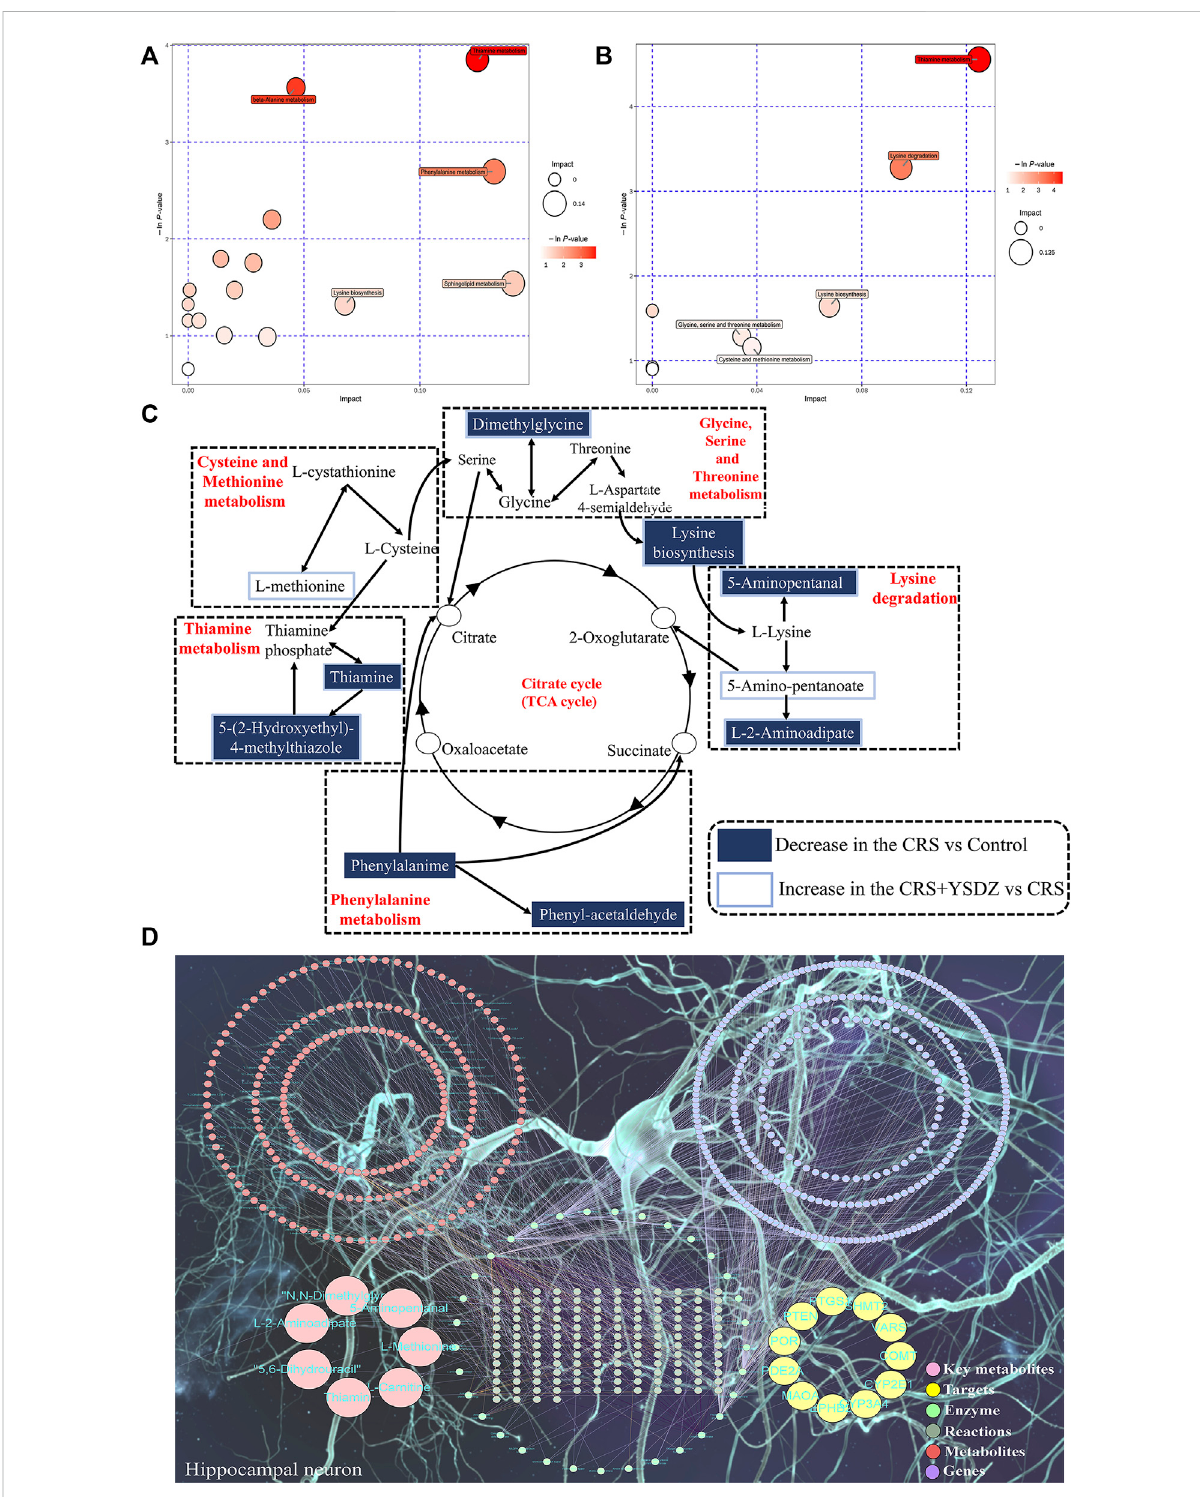
FIGURE 12 Comprehensive analysis of metabolic pathways. (A,B) are Pathway analysis. Each bubble in the bubble map represents a metabolic pathway, where the Y -axis and bubble size represent the impact factor of this pathway in the topology analysis, and the X -axis and bubble color represent the p -value of enrichment analysis. (A) is CRS vs. Control. (B) is CRS + YSDZ vs. CRS. (C) Representative metabolic pathways found in metabolomics analysis. (D) Key metabolite-Target-Enzyme-Reaction-Compound-Gene